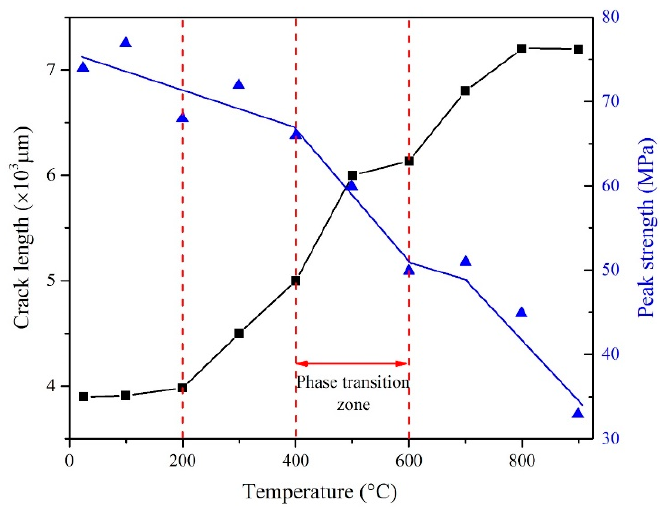
Figure 9. Comparison results between the peak strength and the total length of cracks with temperature.